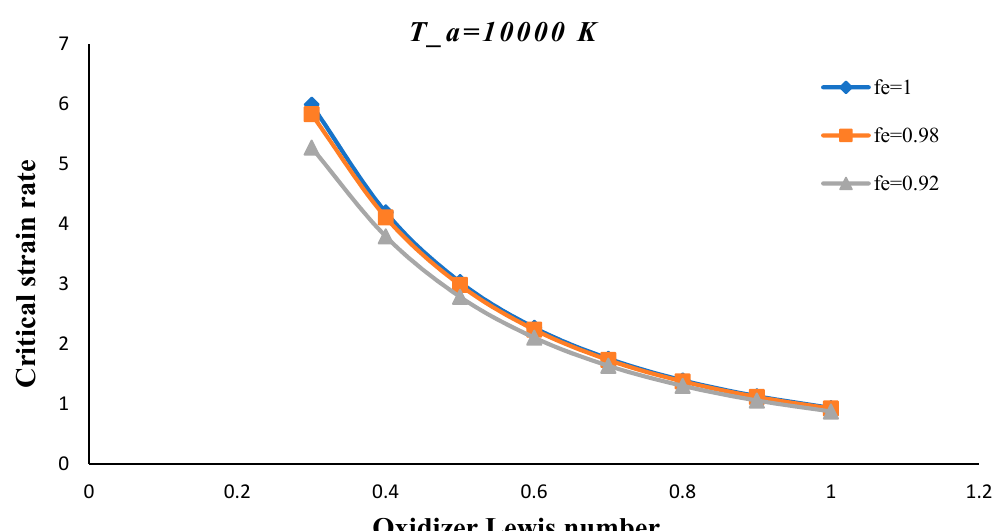
Figure 13. Critical flow strain rate against the oxidizer Lewis number for several porosity factors.